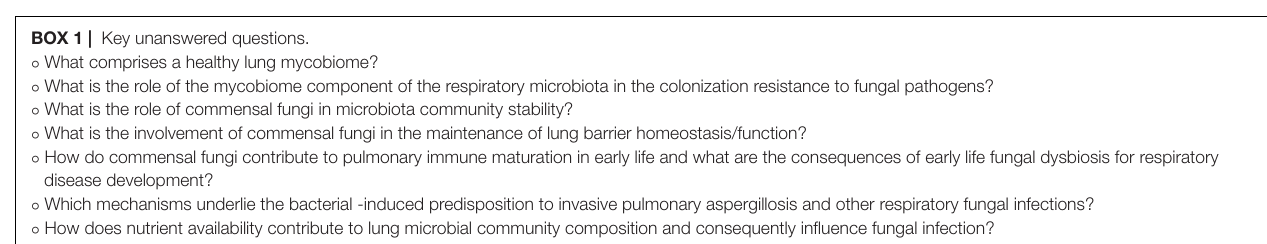
FIGURE 4 | Disease pyramid. The onset of a disease depends on the interplay between the host, the pathogen, the environment, and the host microbiome. Host susceptibility mainly depends on genetic factors and immune status. The main factor for the successful colonization of the host tissues by the pathogen is its virulence. The environment corner refers to the host lung microenvironmental parameters and include among others pH, calcium (Ca 2 + ) and iron (Fe 2 + ) concentrations. Host microbiota community structure can also influence the establishment of the pathogen. Icons have been created using Biorender.com. Modified from Palmieri